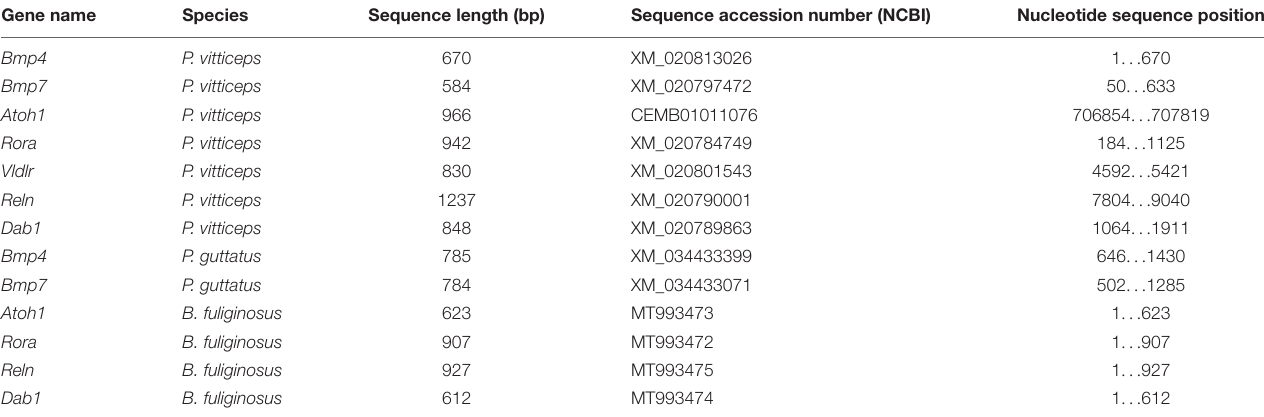
TABLE 1 | Details on nucleotide sequences used to obtain riboprobes in ISH